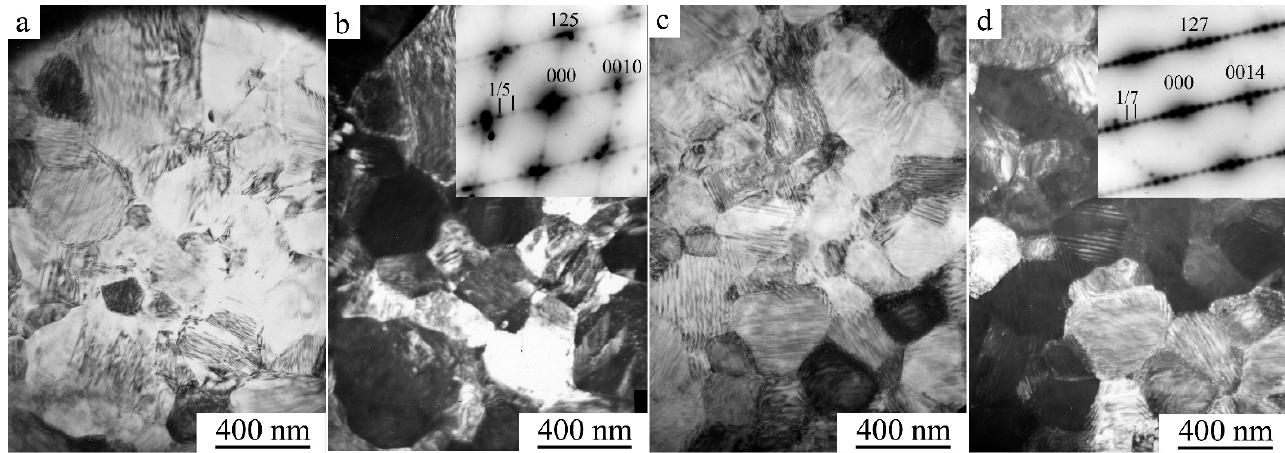
Figure 7. ( a , c ) Bright- and ( b , d ) dark-field TEM images of the microstructure and corresponding SAED patterns (in the inserts) of the Ni 50 Mn 28.5 Ga 21.5 alloy subjected to HPT at 5 GPa and five revolutions and subsequent annealing at 773 K for 10 min. Observations were performed at ( a , b ) RT and ( c , d ) 120 K.